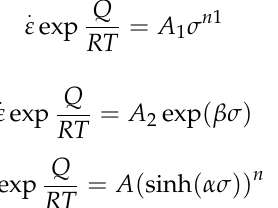
Figure 2. True stress-True strain curves under elevated temperatures and strain rates. ( a ) . ε = 0.1s − 1 ; ( c ) ( b )